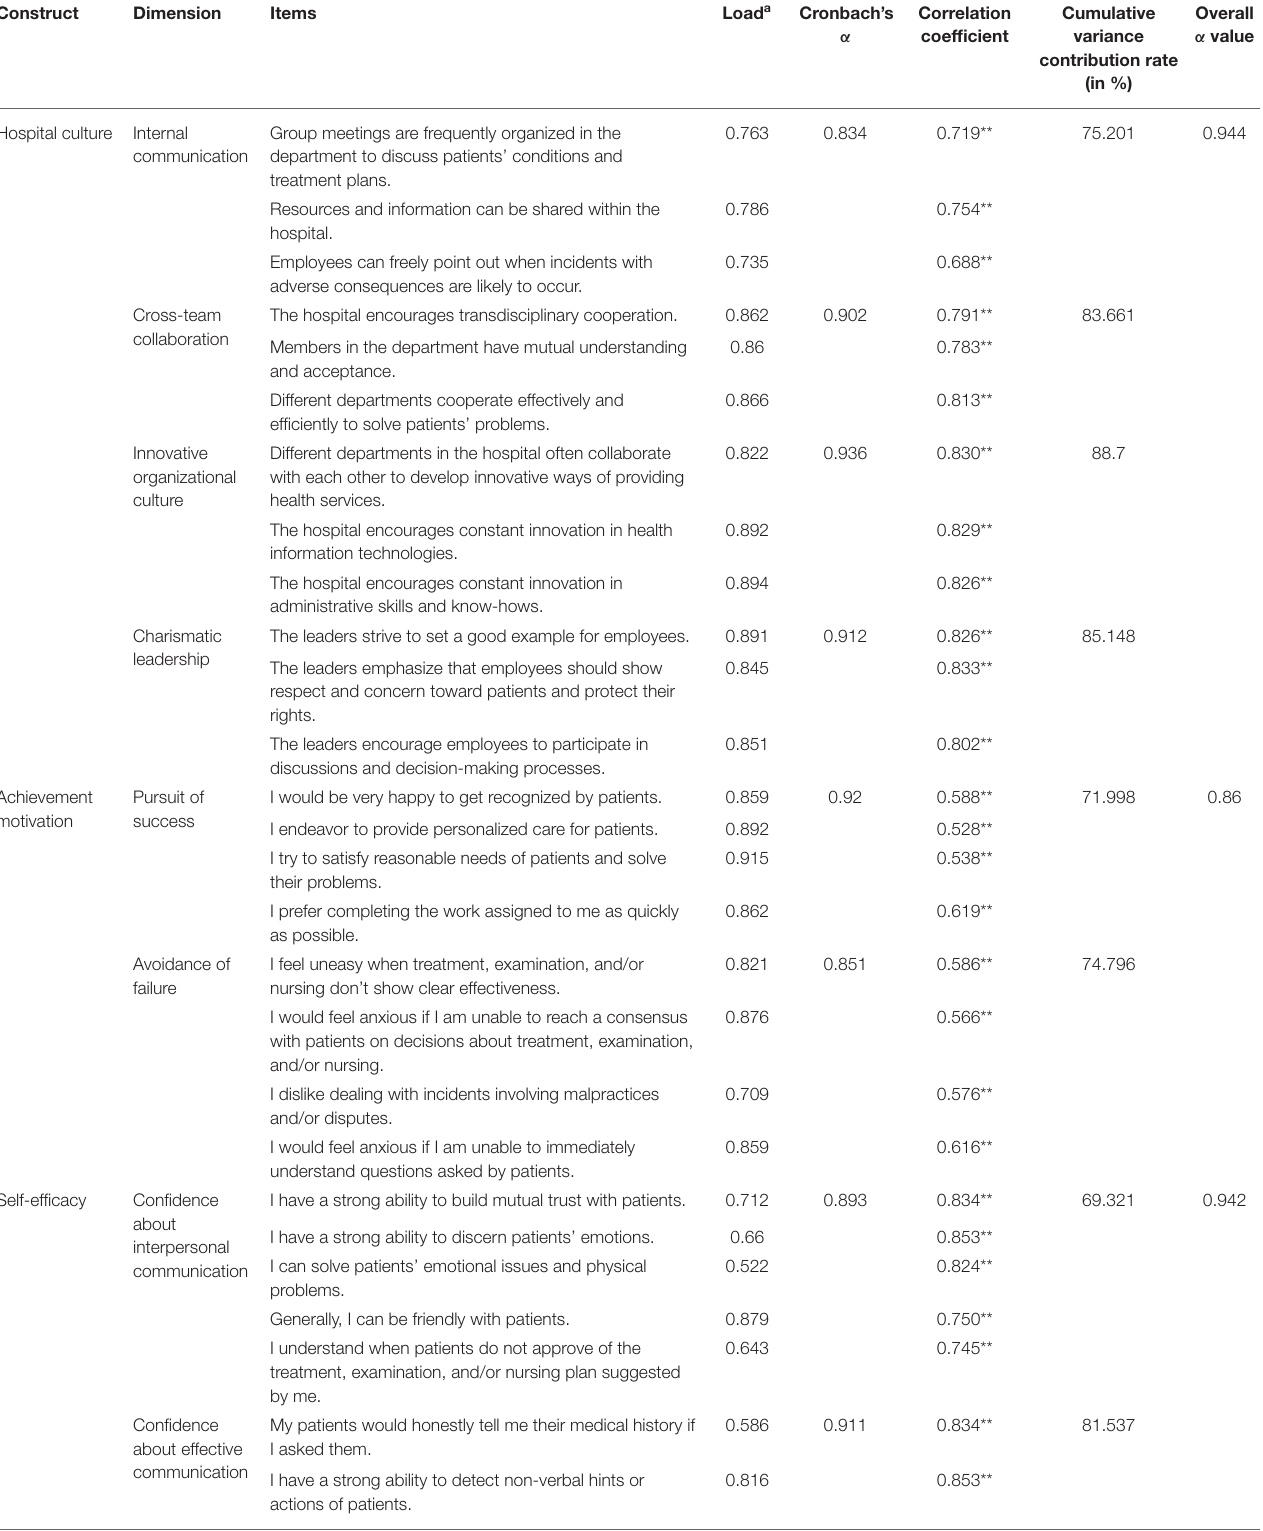
TABLE 1 | Description, factor analysis, and reliability coefficients of construct measures. Construct